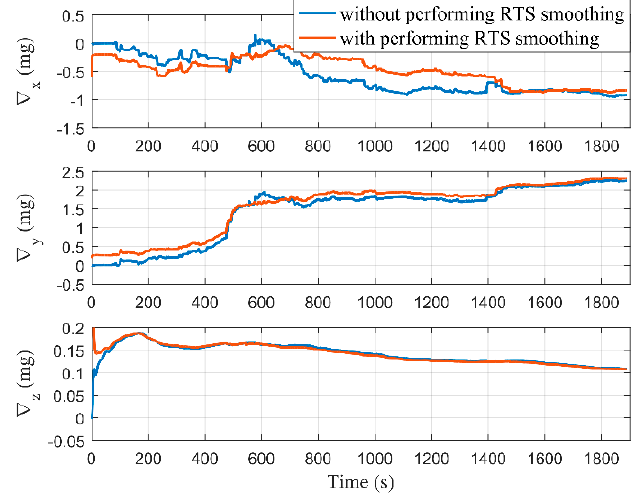
Figure 9. Estimation results of the accelerometer biases with and without performing RTS smoothing.